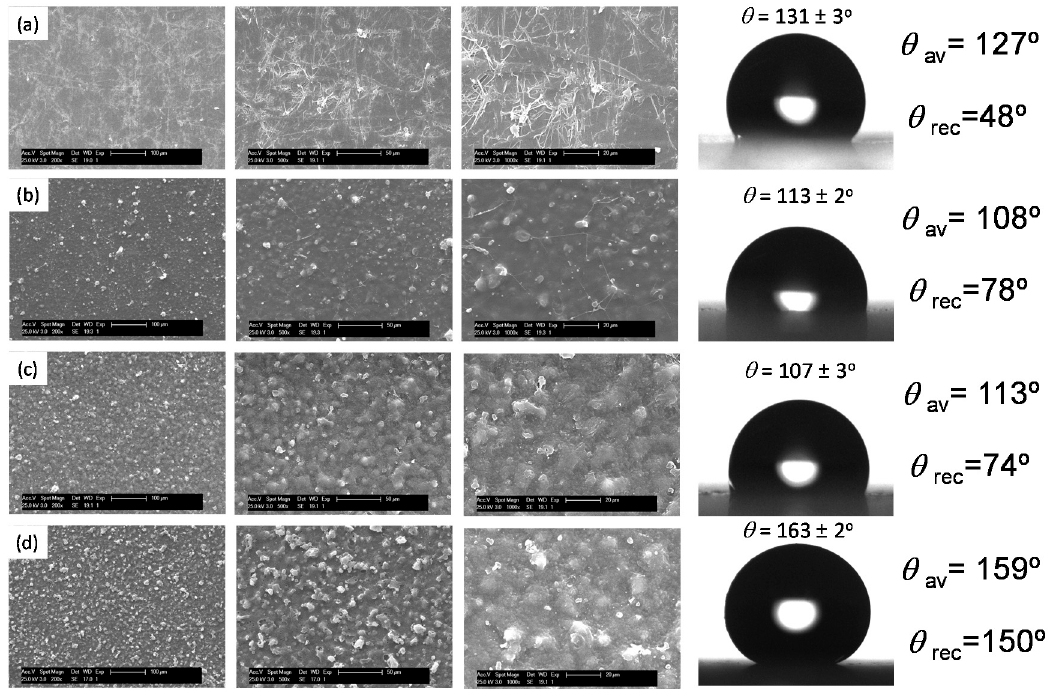
Figure 5. SEM images and contact angles of the surfaces obtained upon spraying ( a ) PS; ( b ) a 50/50 wt % blend of PS/PS- co -P5FS; ( c ) a 25/75 wt % blend of PS/PS- co -P5FS and finally ( d ) the pure PS- co -P5FS. The sprayed solutions have a total concentration of 50 mg/mL solutions. The number of layers deposed is 10. θ av = advancing contact angle, θ rec = receding contact angle.